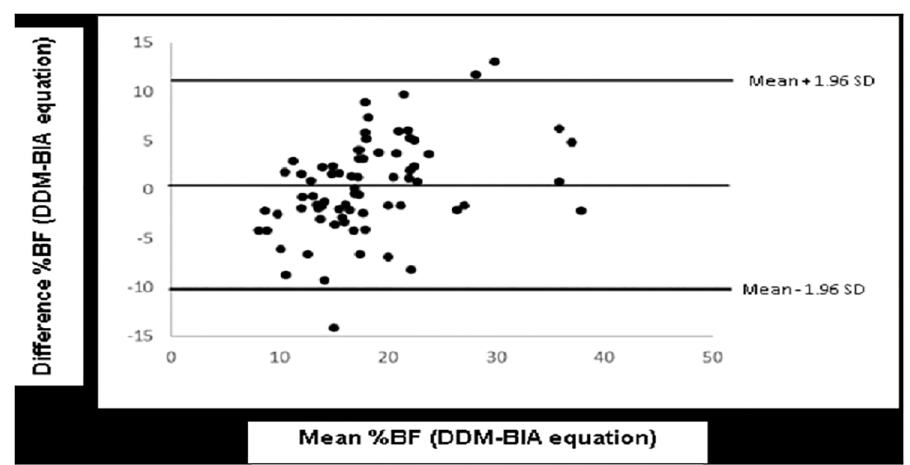
Fig 4. Bland and Altman plot of the differences between %BF measured by DDM and predicted by the BIA equation against their mean. The horizontal line represents the bias and the upper and lower horizontal lines indicate the 95% CI limits of agreement ( ± 1.96 x SD) for